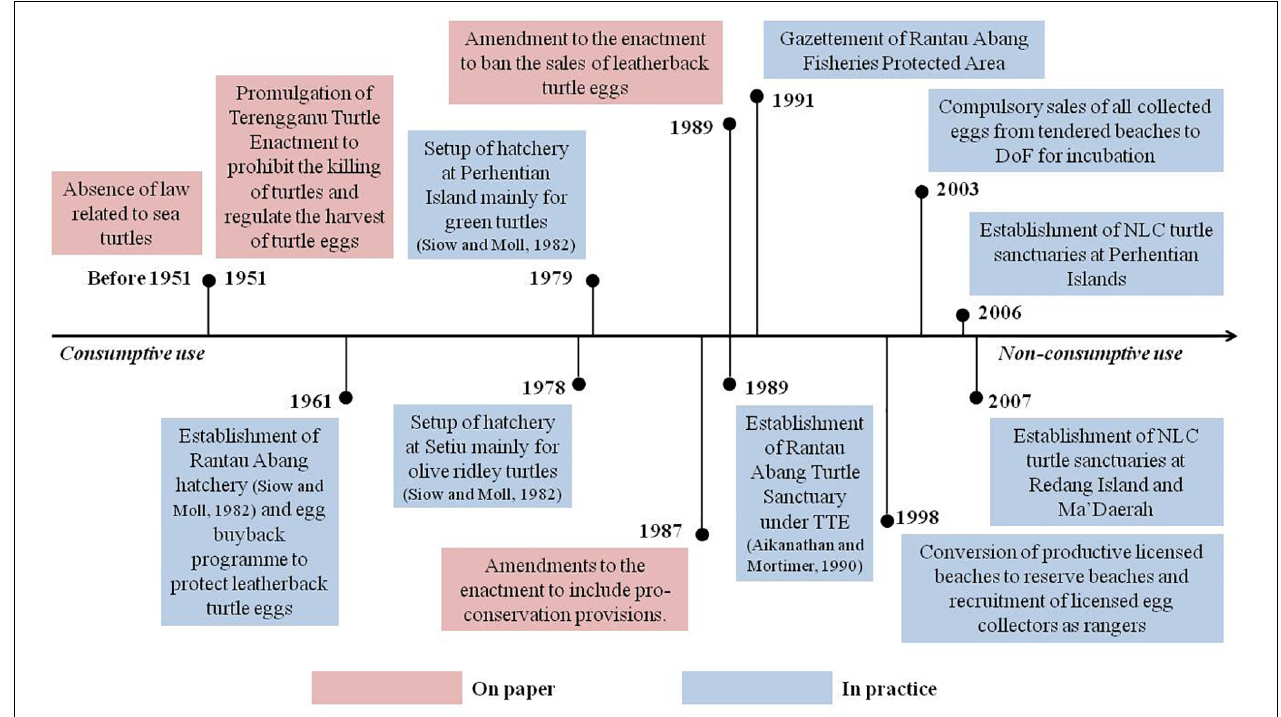
FIGURE 2 | Chronological progress of TTE transformation in